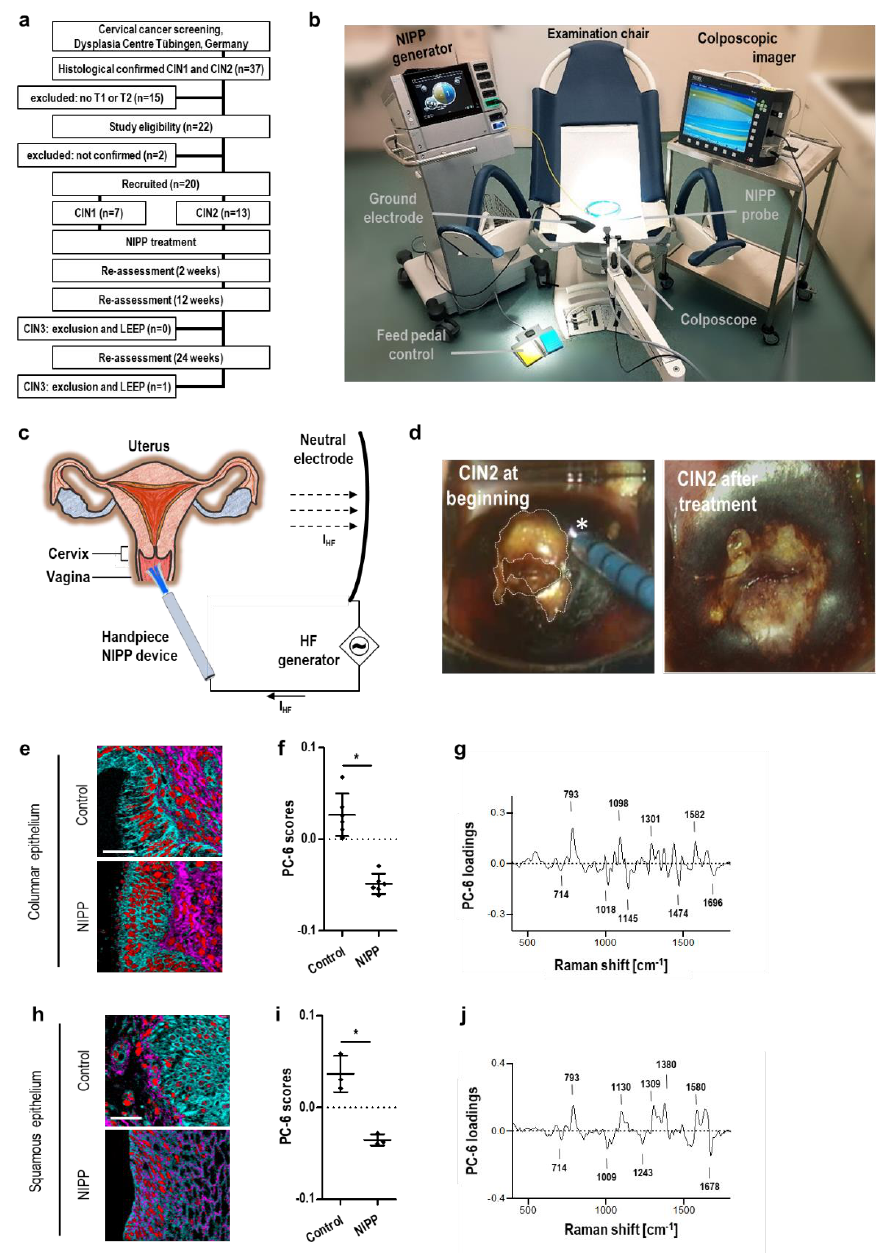
Figure 3. In vivo NIPP treatment and evaluation of molecular tissue effects, penetration depth and clinical efficacy. ( a ) Trial flow chart of patient recruitment and study visits for the prospective clinical study. ( b ) Setup of in vivo NIPP treatment. ( c ) Schematic of the anatomical view of the human cervix. As the uterine portion of the vaginal cavity, the cervix is easily accessible for NIPP treatment. ( d ) Colposcopic image of a human cervix after staining with 4% acetic acid and Lugol’s iodine at beginning ( left ) and after ( right ) NIPP treatment (30 s/cm 2 ). The transformation zone is completely visible (T1 transformation zone; dashed line). The NIPP effluent is marked by an asterisk. ( e – j ) Columnar ( e – g ) and squamous ( h – j ) epithelium of tissue sections from patients treated with NIPP in vivo at 30 s/cm 2 and tissue biopsies before treatment (control) were analyzed by Raman imaging. ( e , h ) Nuclei (red), collagen I (pink) and cytoplasmic proteins (light blue) were localized by TCA; the scale bar equals 50 µ m. ( f , i ) The nuclear spectra obtained in ( e , h ) were processed by PCA, and the average PC score values of each patient ( (cid:117) ) were statistically compared (mean ± SD; paired t test; * p < 0.05). ( g , j ) Underlying biochemical information was interpreted based on relevant spectral signatures elaborated in the loading